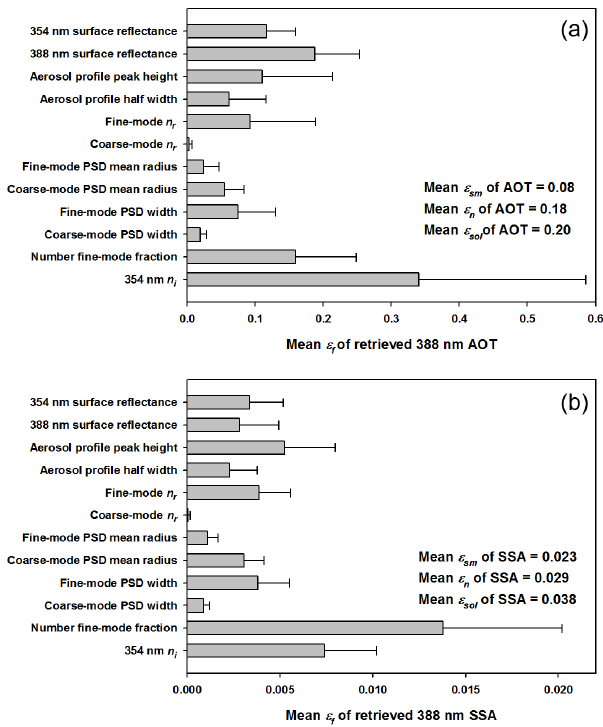
Figure 9. Average (gray bars) and standard deviation (black lines) of the forward model parameter errors of 388nm (a) AOT and (b)